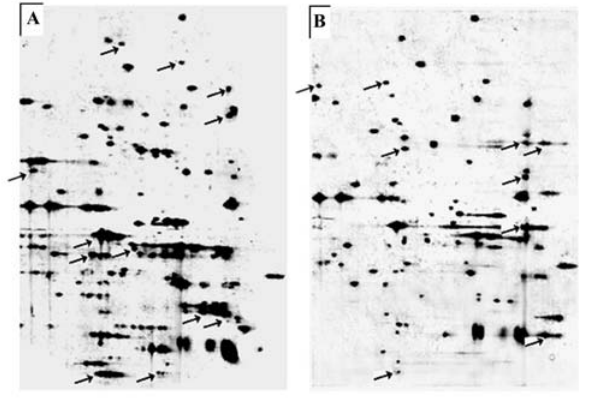
FIGURE 3. Electrophoregram of polypeptides of vegetative cells (A) and ultramicroforms (B) of A. laidlawii PG8. The arrows mark the polypeptides different in the mycoplasma cells.